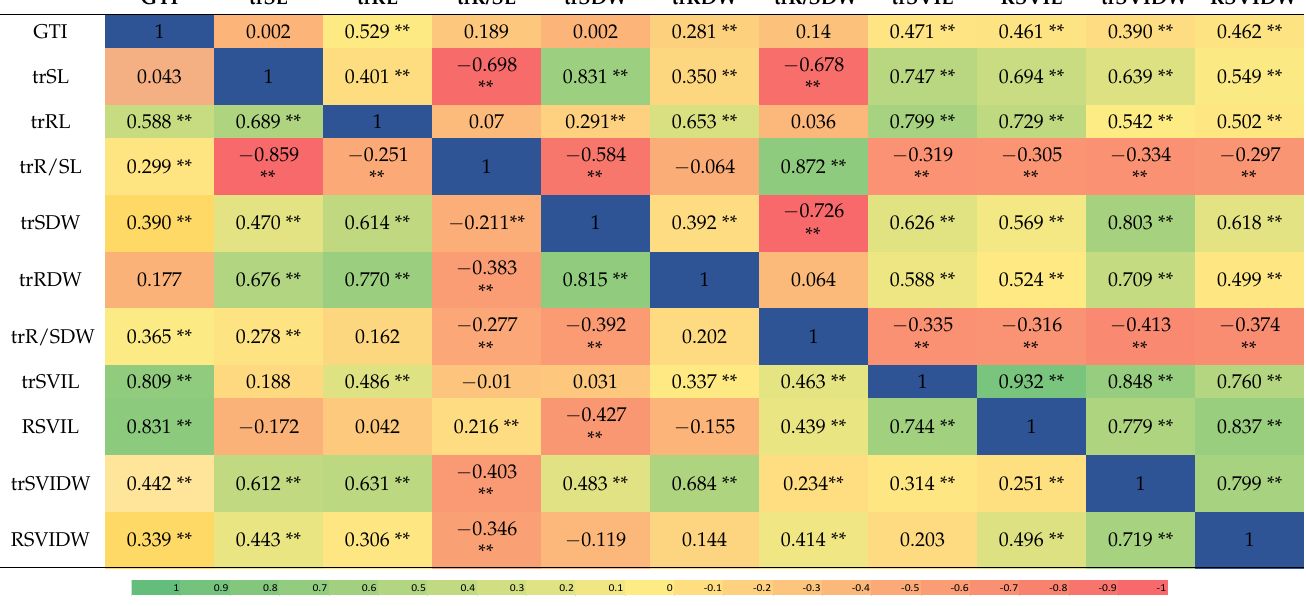
Table 2. Pearson correlation among seedling survival traits of diverse barley panel (above) and CM72/Gairdner DH (below main diagonal) in 150 mM